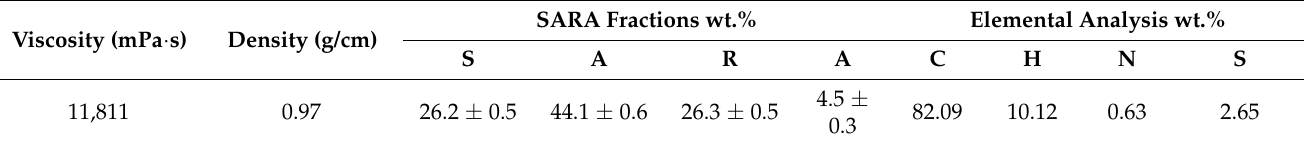
Table 3. Viscosity, density, SARA fractions, and elemental analysis of the studied heavy crude oil. SARA Fractions wt.% Elemental Analysis wt.% Viscosity (mPa · s) Density (g/cm) S A R A C H N S 11,811